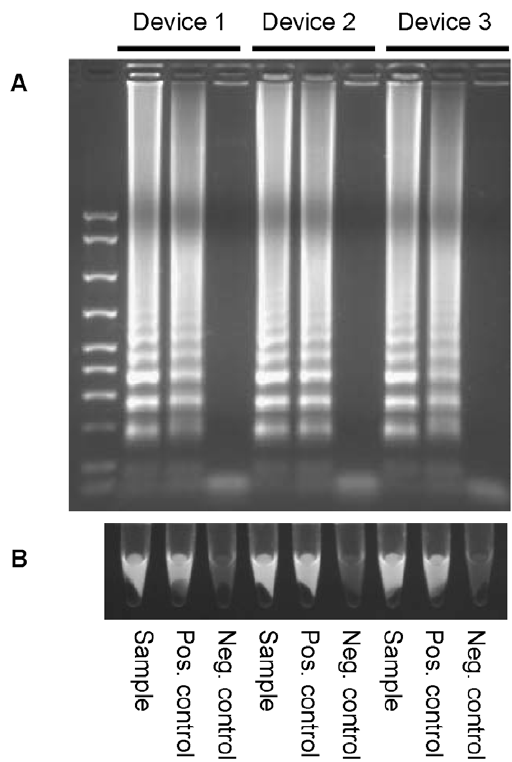
Figure 3. Validation of NINA heaters with clinical specimens. The amplification results from a representative clinical specimen are displayed in the figure. Whole blood from an HIV-1 infected patient was added directly into the RT-LAMP reaction and amplification in all 3 NINA heaters was compared. Amplified material was analyzed by (A) agarose gel electrophoresis or (B) by observing fluorescence in the reaction tubes under a UV light.